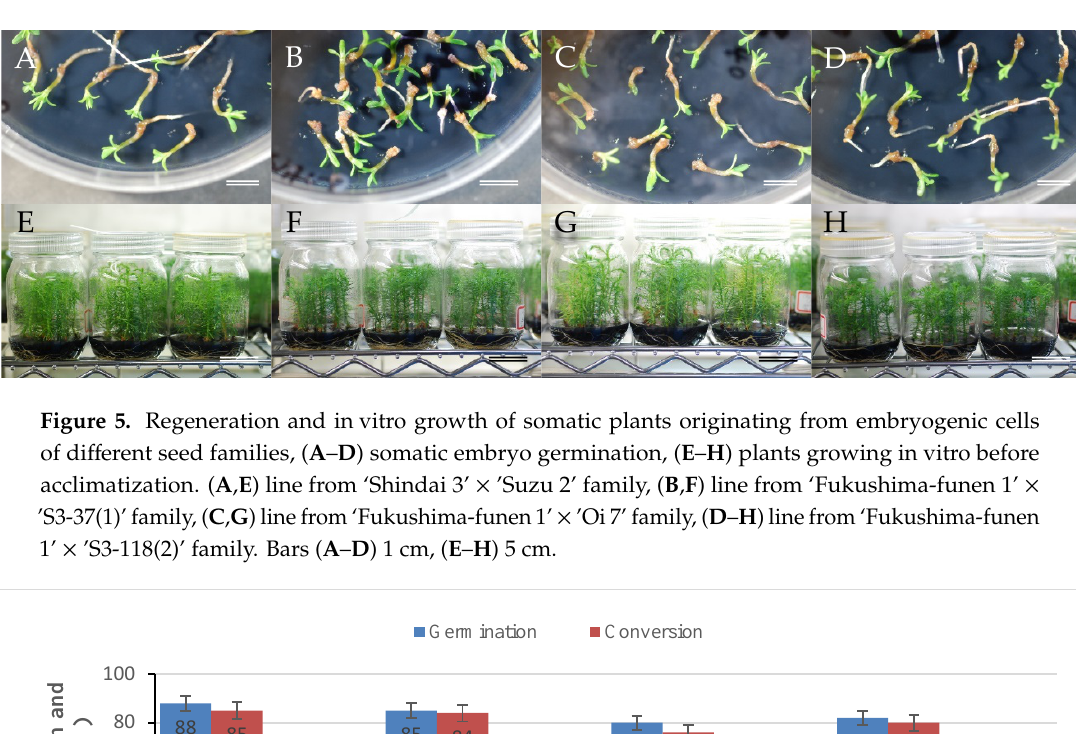
6 of 15 Figure 4. Somatic embryo production efficiency of sugi seed families carrying the male sterility gene MS1 . Data represent the mean ± SE of somatic embryos per plate (cotyledonary embryos per 0.5 g) from ten male sterile lines per seed family. The lower case letters indicate significant differences according to Tukey’s multiple range test at p < 0.05. Although the number of mature somatic embryos produced varied among the seed families, the induction of somatic embryos was confirmed in all families, with an average production of at least 100 cotyledonary embryos per plate (equivalent to 200 embryos per gram). This value compares well with those listed earlier for other conifers. Differences in successful somatic embryo production among seed families, as observed here for the male sterile lines, were also found in male fertile sugi